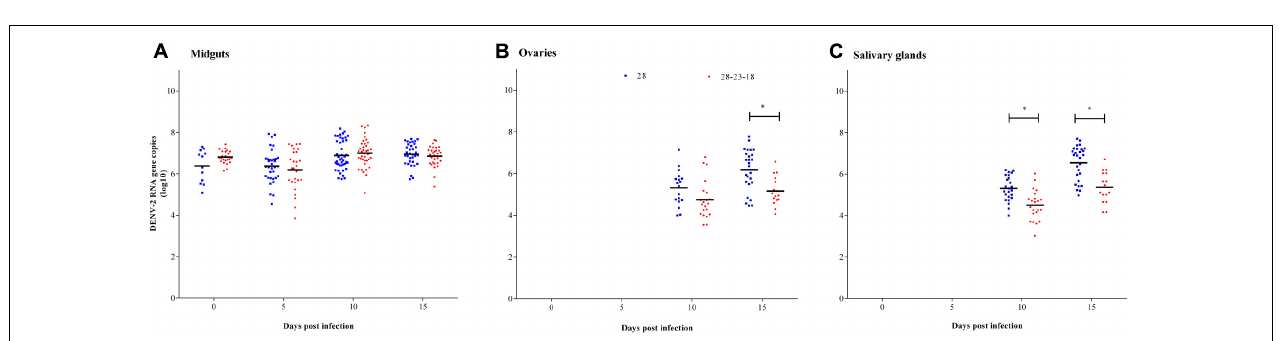
FIGURE 3 | DENV-2 RNA copies in tissues of Ae. albopictus at the constant temperature. The amount of DENV-2 in the positive tissues of Ae. albopictus was further detected by qRT-PCR. (A) Midguts; (B) ovaries; (C) salivary glands. Horizontal black lines show median DENV-2 copies (log 10 ) at each temperature.